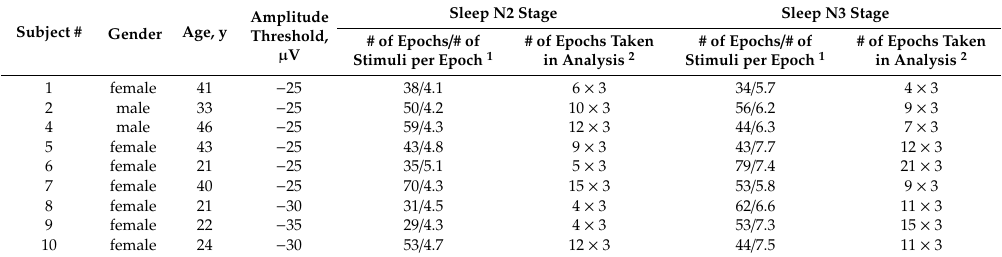
Table 1. Characteristics of test participants and stimulation